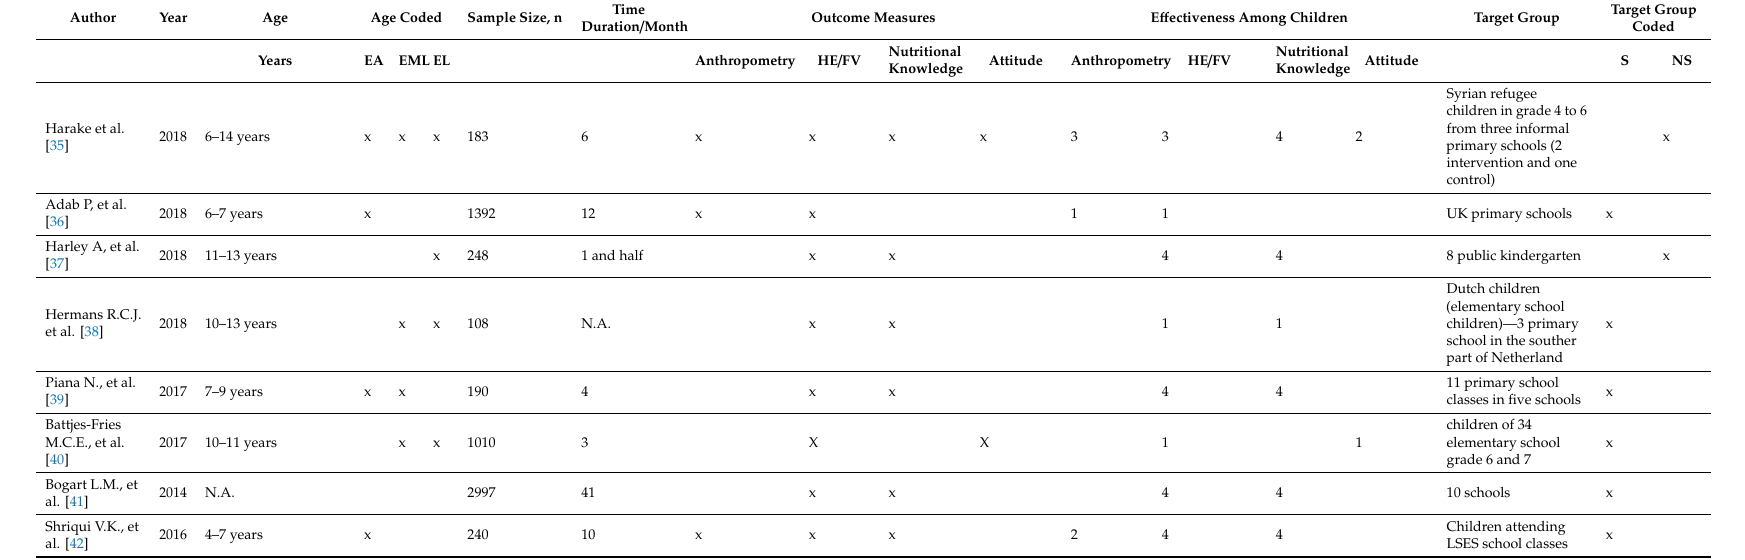
Table 3. The review sample-findings. The table shows the findings from the 43 studies of the